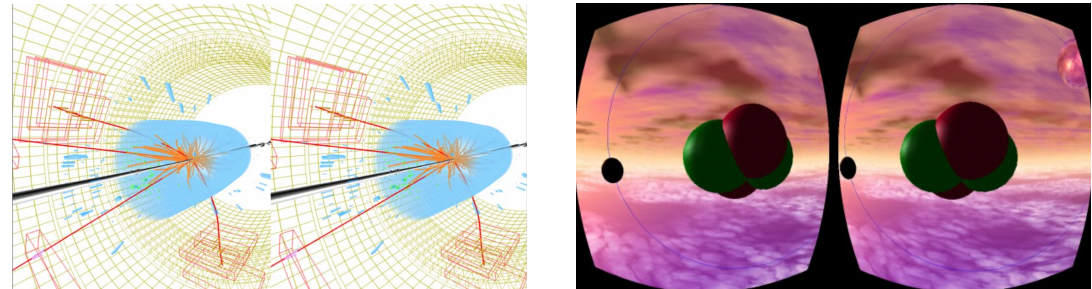
Figure 9. Examples of VR for physical applications on mobile phones. Left: iSpy WebGL [74] renders a collision event from CERN on a mobile phone in binocular mode. Right: Yeh et al. [75] showing the 3D stereoscopic virtual reality of a helium atom with their tool